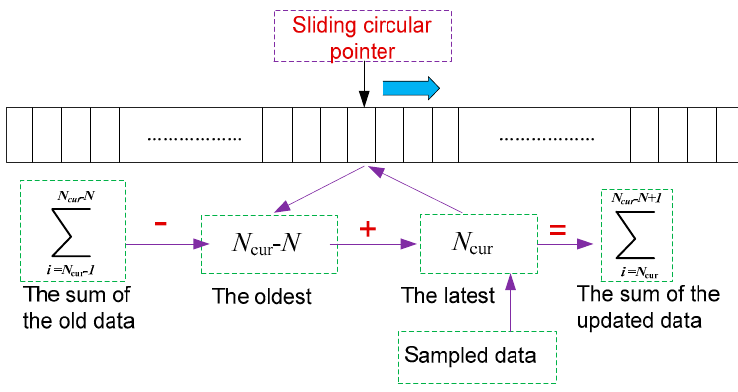
Figure 8. The sliding window iterative discrete Fourier transformation (DFT) method.